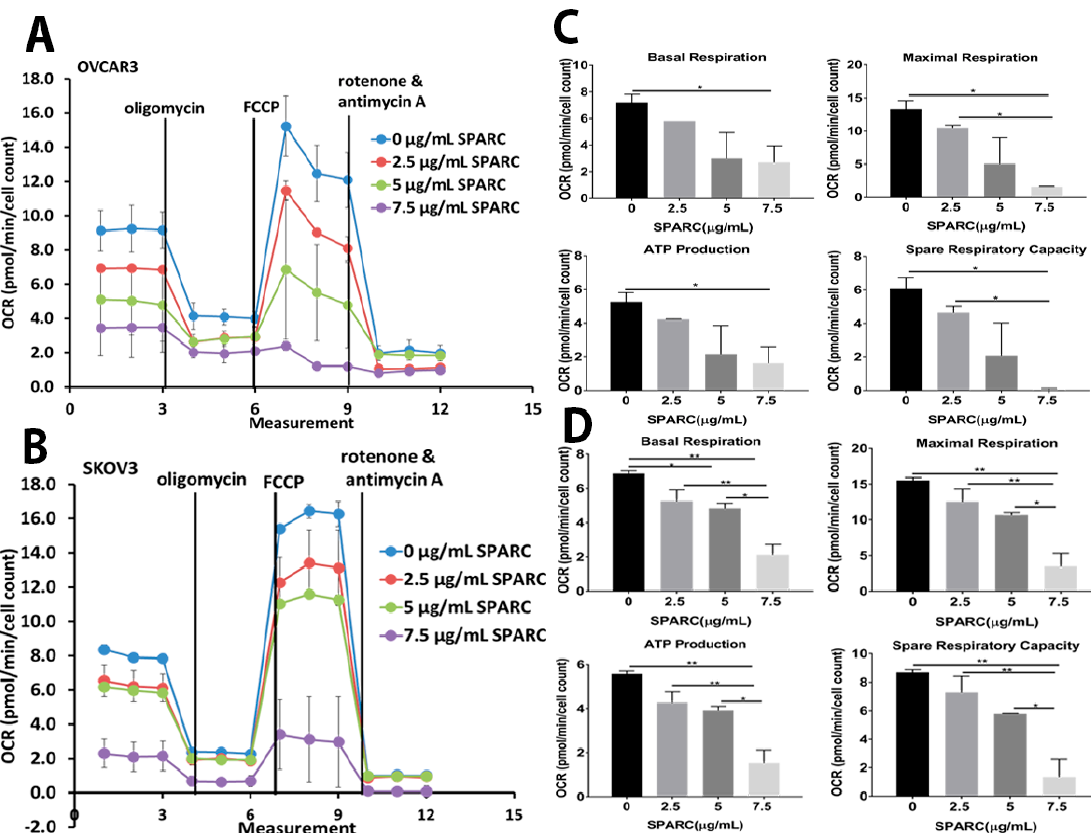
Figure 6. Effect of SPARC on mitochondrial functions and bioenergetics. ( A , B ) Seahorse tracing of the oxygen consumption rate in OVCAR3 and SKOV3 treated with the indicated concentrations of SPARC for 24 h, followed by mitochondrial stress test as described in material and methods. ( C , D ) Bar graphs of means ± SEM of the basal and maximal respiration, ATP production and spare respiratory in OVCAR3 and SKOV3 cells treated with SPARC recorded in a representative of three experiments (Five replica/experimental condition/experiment). * p < 0.05, ** p < 0.01, one-way ANOVA with Tuckey’s post-hoc test.